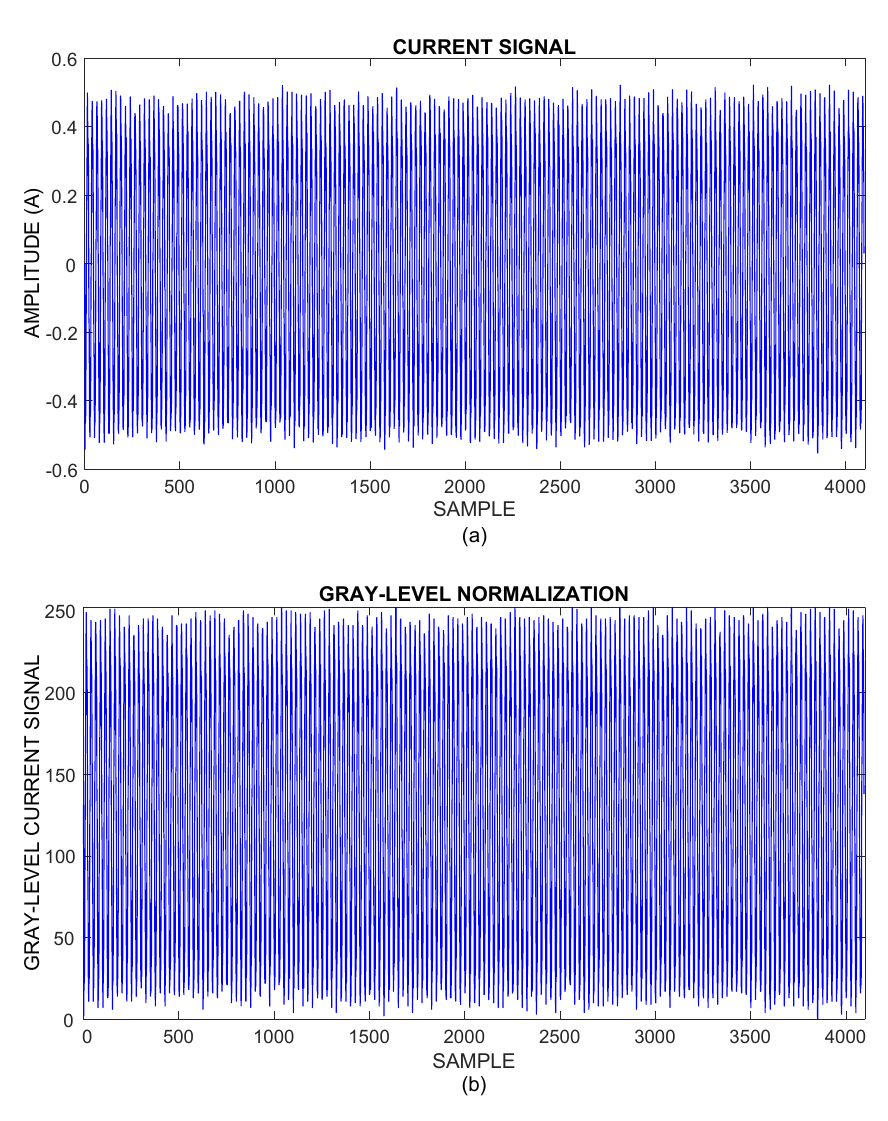
Figure 4. Proposed methodology for BRB detection.